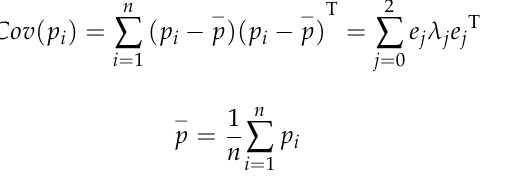
Figure 3. Technology roadmap. ( I ) Rough extraction of vegetation point cloud and building point cloud; ( II ) Removing the building boundary point cloud in the vegetation point cloud; ( III ) Accurate extraction of vegetation point cloud.